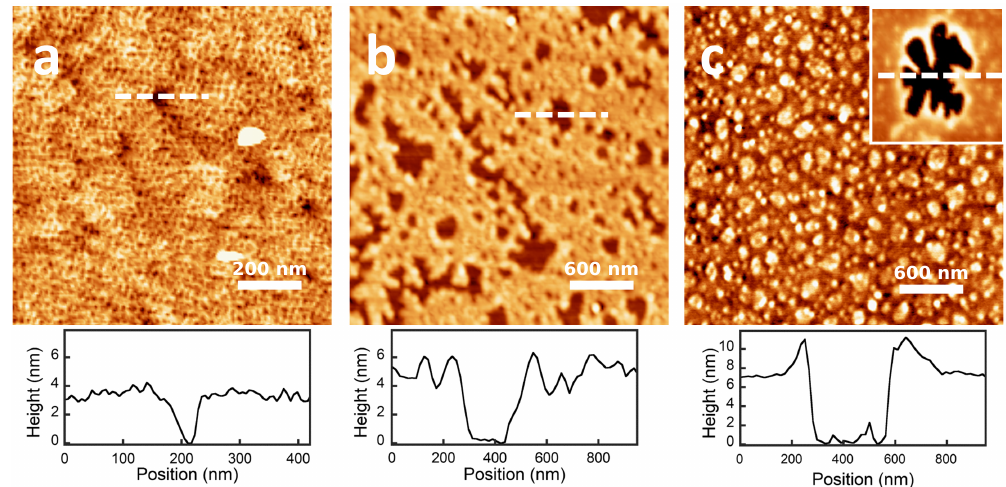
Figure 5. Height AFM micrographs in air of the dry protein films adsorbed onto SAM gold surfaces of CH 3 . ( a ) β -lactoglobulin; ( b ) BSA and ( c ) β -casein films. A typical height profile for each sample is presented. Values for the thickness of the films are compiled in Table 2. Scales are indicated in the figure.